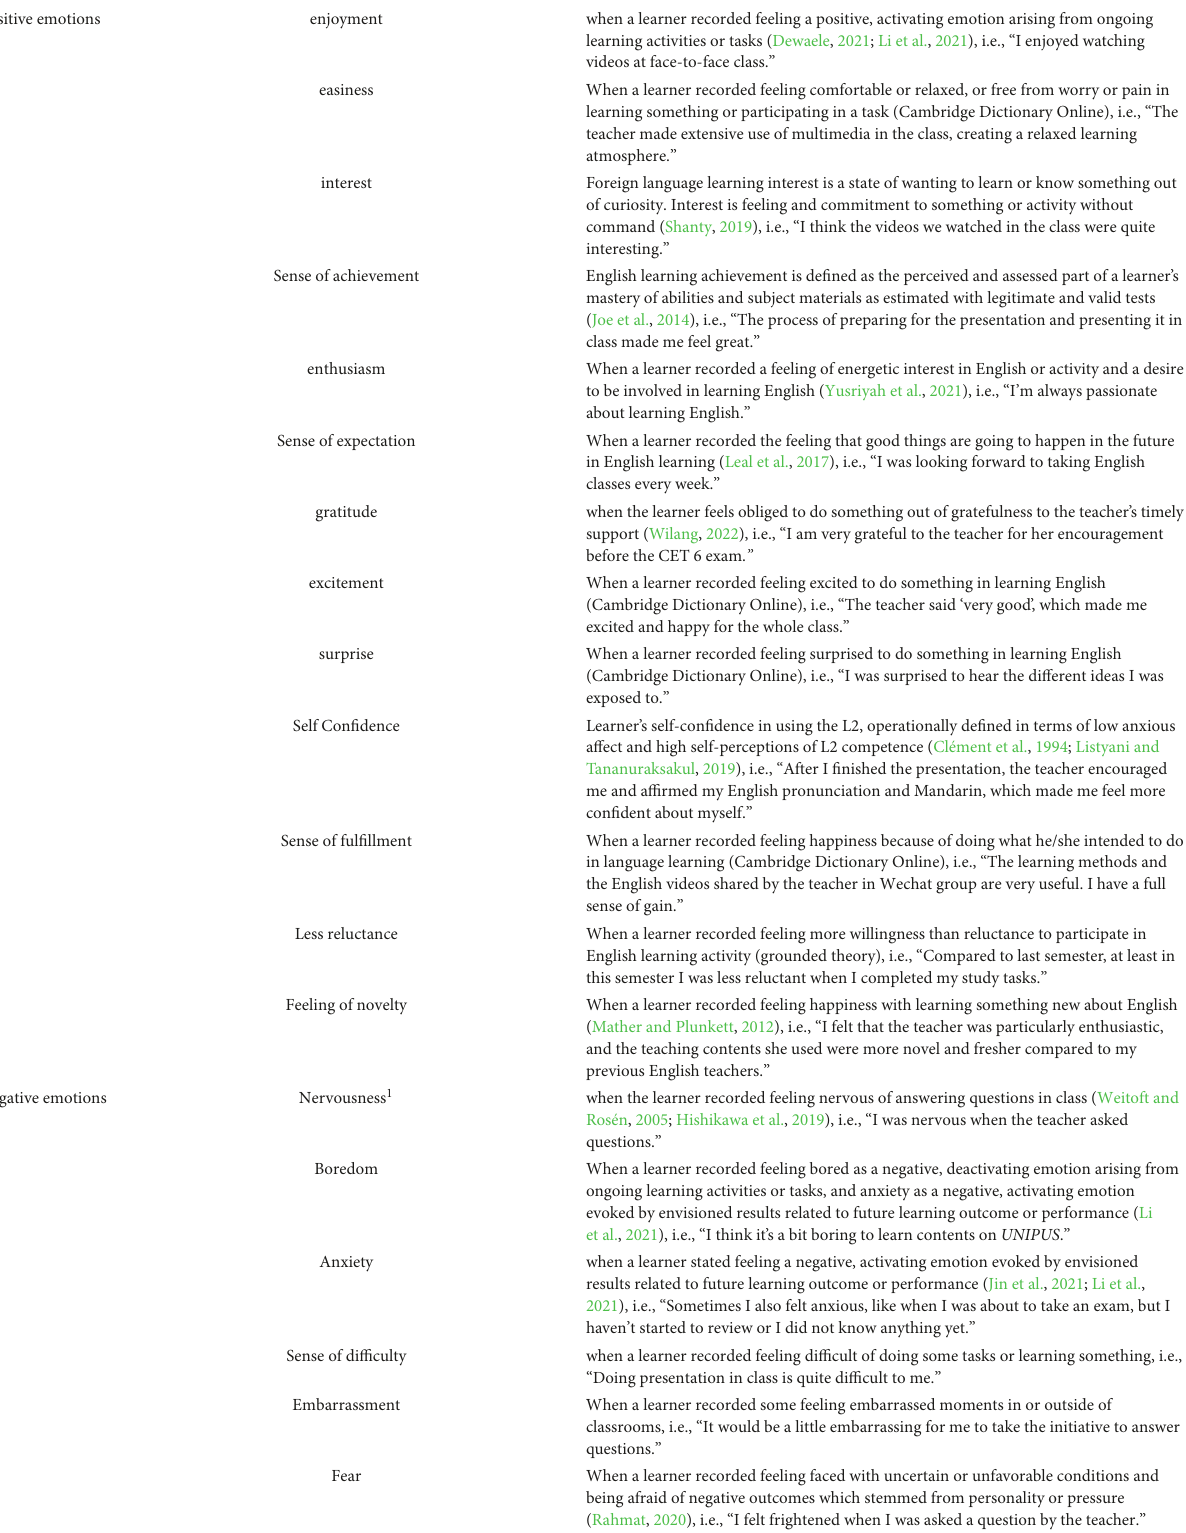
TABLE 4 Coding scheme of varieties of learners’ emotions emerged in narrative